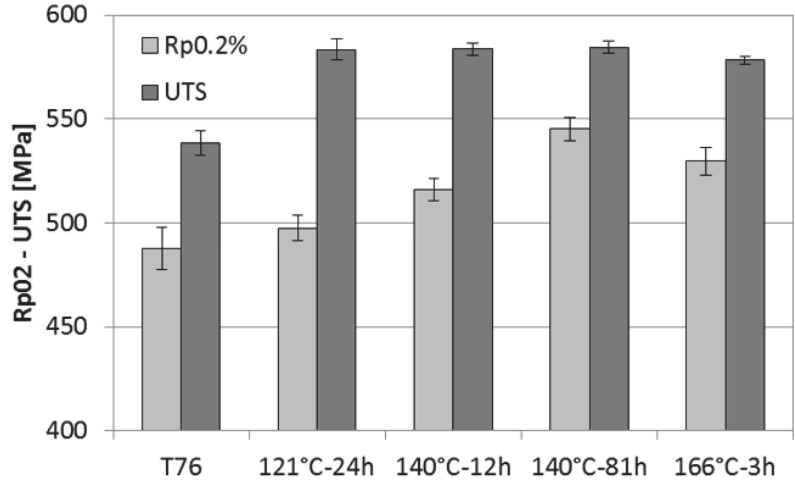
Figure 5: Comparison between the yield and UTS values obtained .